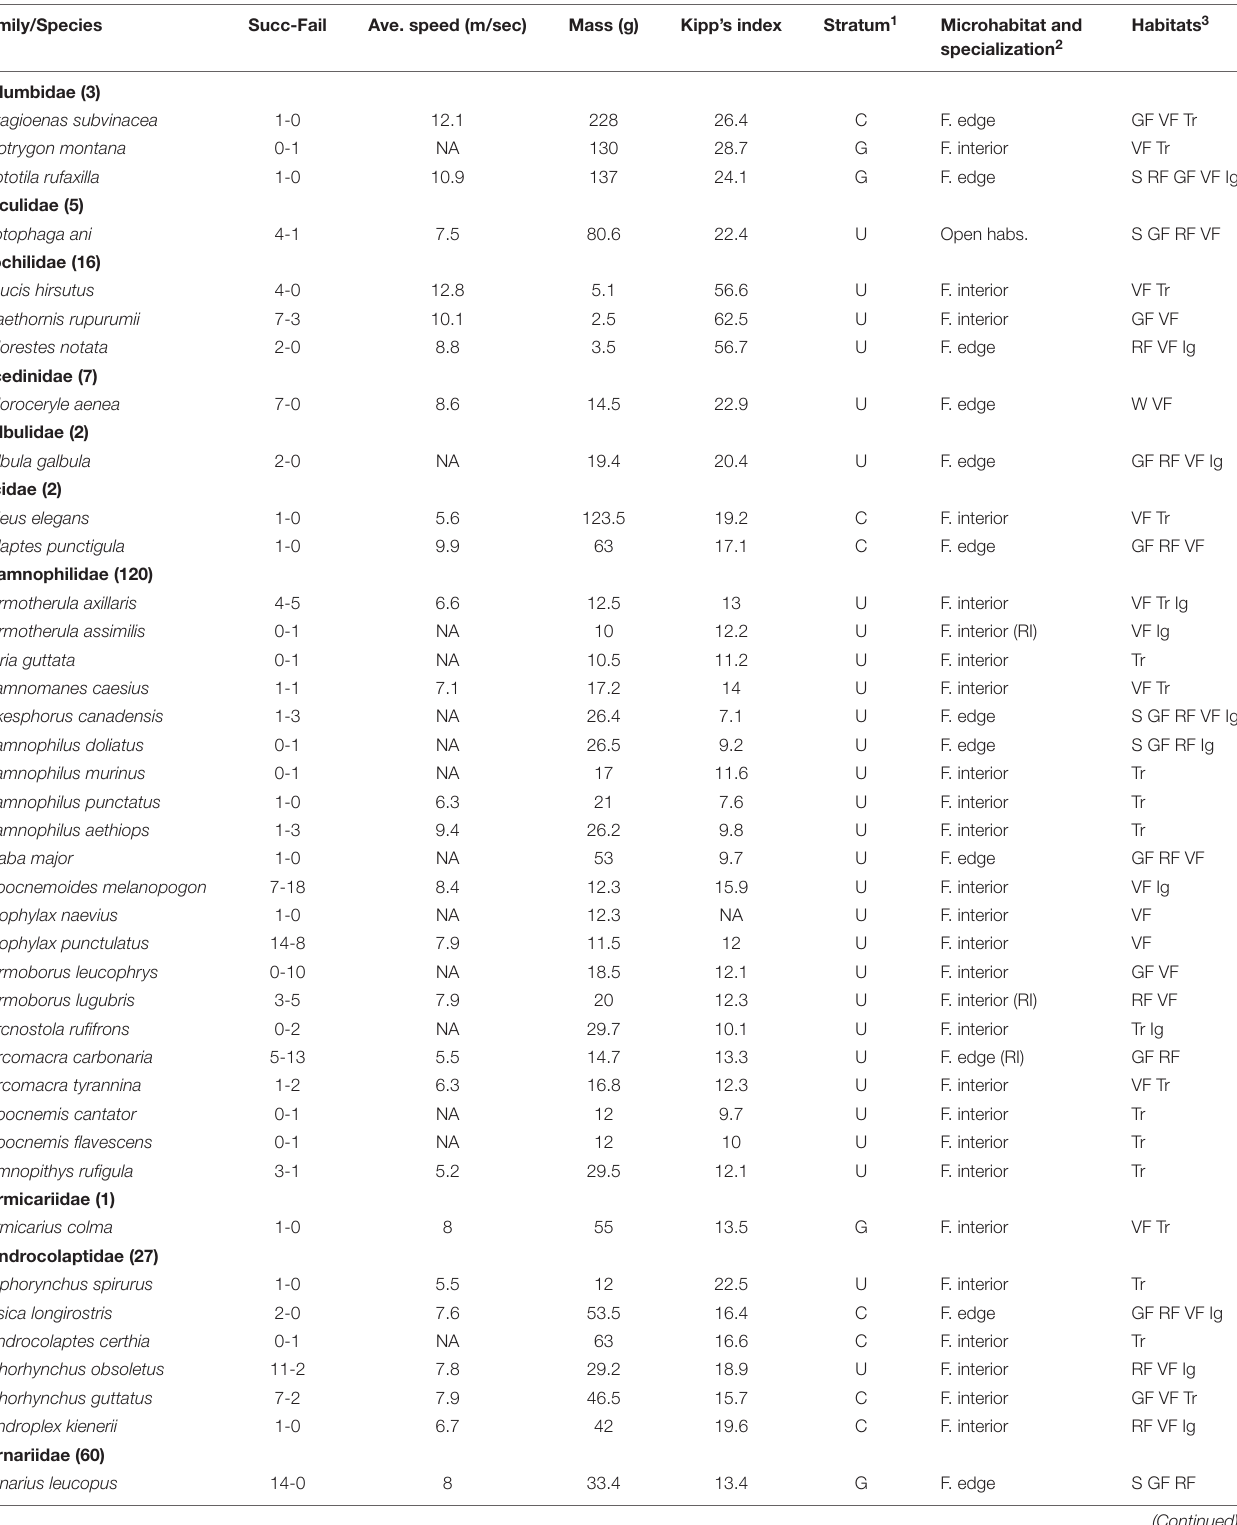
TABLE 1 | Eighty-four (84) bird species included in the dispersal experiments, including rates of success and failure, average speed, and main habitats, microhabitat and stratum used based by each species (based on Naka et al., 2020). Numbers in parentheses after family names indicate the number of experiments per family. Family/Species Succ-Fail Ave. speed (m/sec) Mass (g) Kipp’s index Stratum 1 Microhabitat and